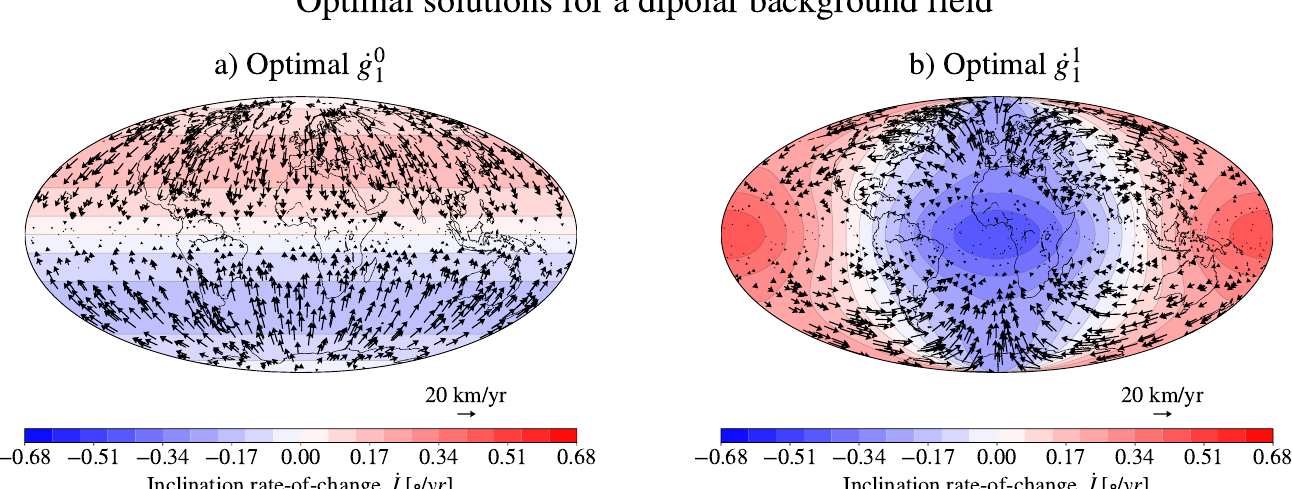
Figure A1. Flows that optimise the rate of change of ( a ) g 0 and ( b ) g 1 with a background magnetic field given by an axial 1 1 = − 29410.65 nT and T = 13 km/y. The arrows indicate the direction and intensity of the flow, and the dipole with g 0 0 1 colour scale indicates the resulting rate of change in